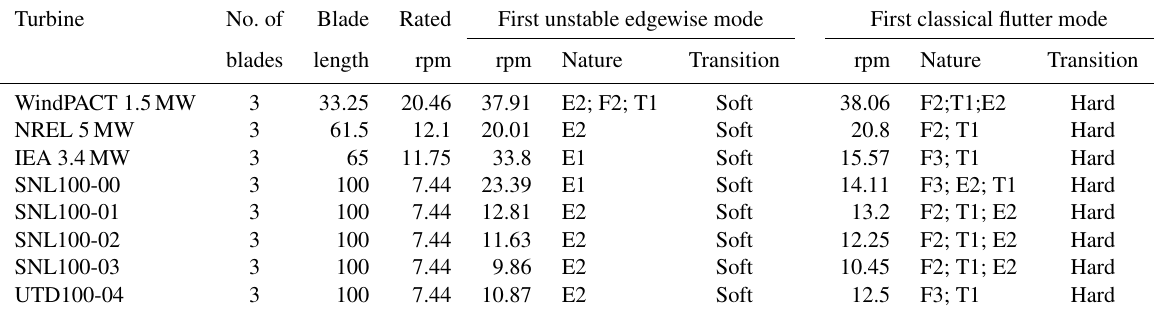
Table 4. Flutter speeds for three-bladed wind turbine models. E = edgewise, F = flapwise, T = torsional. The numbers next to the mode type indicate the mode order. The modes are arranged according to highest to lowest contribution. Turbine No. of Blade Rated First unstable edgewise mode First classical flutter mode blades length rpm rpm Nature Transition rpm Nature Transition WindPACT